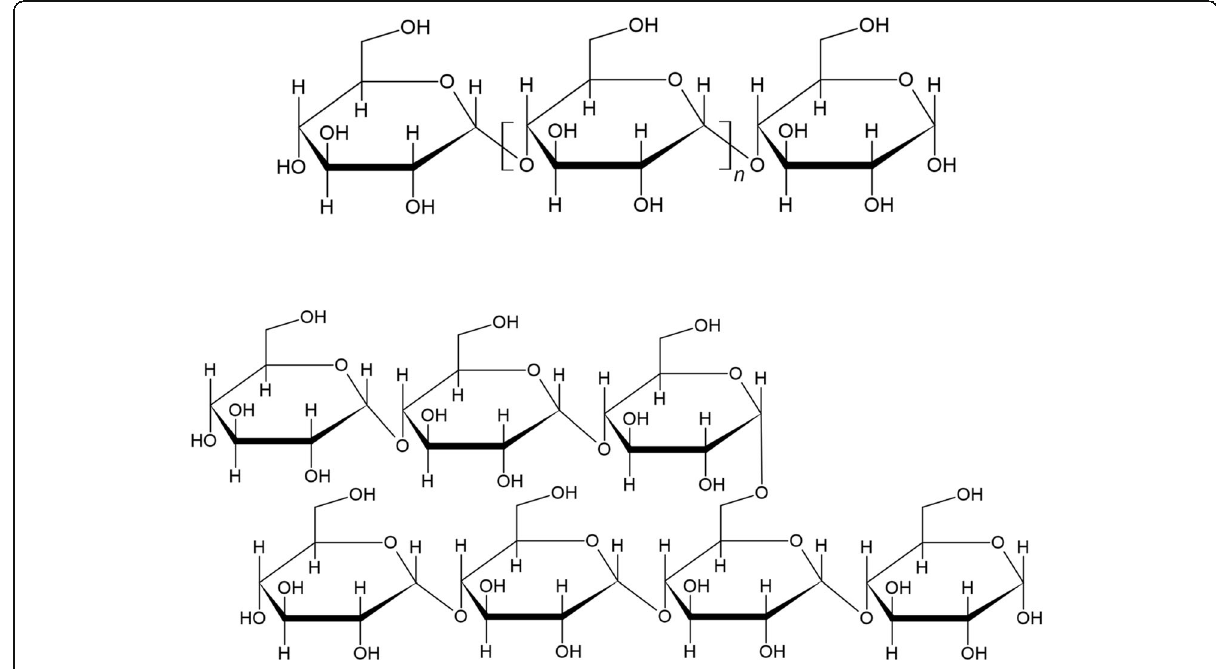
Fig. 4 Polymers that constitute starch: ( A ) amylose, ( B ) amylopectin